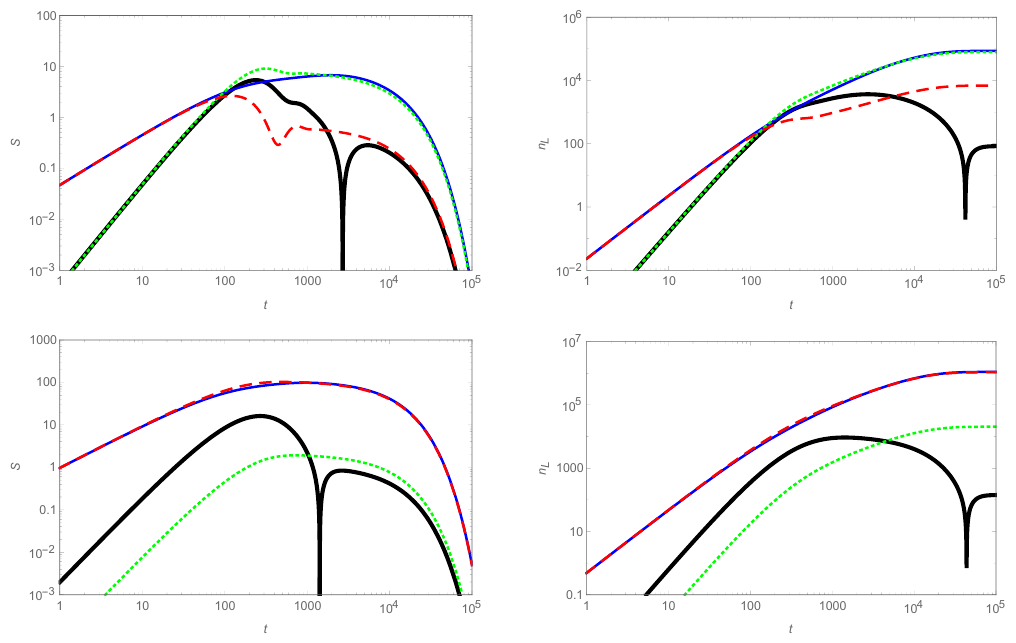
Figure 2 . Absolute value of the contributions to the source term (left plots) and lepton asymmetry (right plots), as a function of time normalized to γ/M 1 . The solid blue lines represent the mixing contribution (according to eq. (2.22)), the dotted green lines the oscillation contribution (eq. (2.23)), the dashed red lines the interference contribution (eq. (2.24)), and the thick solid black lines give the absolute value of the sum of all contributions, i.e. the total source term (eq. (3.2)) for the left plots and the net lepton asymmetry for the right ones. In the top plots we have chosen Γ 1 /M 1 = 1 / 100 , Γ 2 /M 1 = 1 / 1000 and ∆ M = Γ 1 , while the corresponding quantities with tilde differ by no more than 10% in this case. For the bottom plots, Γ 1 /M 1 = 1 / 100 , Γ 2 /M 1 = 1 / 130 and ∆ M = 0 . 2 Γ 1 , so that ˜Γ 1 /M 1 ’ 0 . 015 , ˜Γ 2 /M 1 ’ 0 . 003 and ∆ ˜ M ’ 0 . 03 ˜Γ 1 . In all cases we have taken h 1 = | h 1 | and h 2 = | h 2 | e iφ , with φ = π/ 4 . The lepton asymmetry has been obtained integrating only the